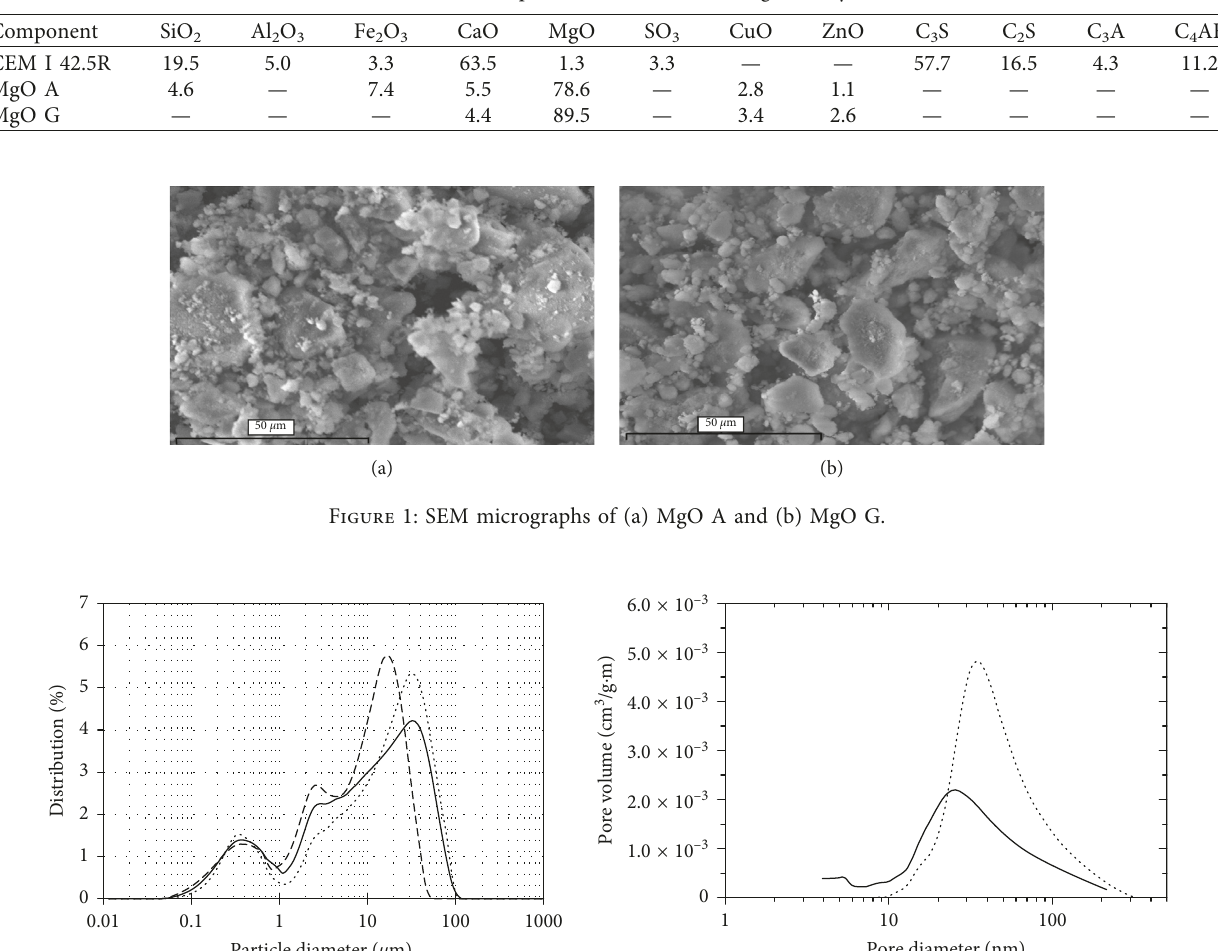
Table 1: Chemical composition of cement and MgO (% by mass).